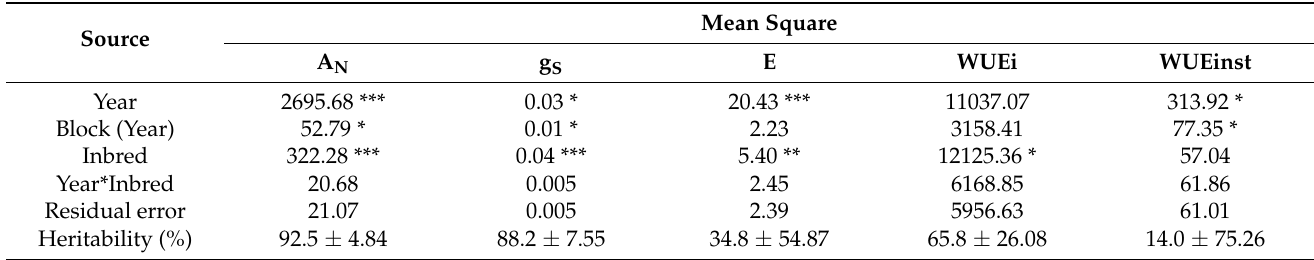
Table 2. Mean squares of the combined analysis of variance of the inbred panel across three years and heritability ( ± standard deviation) estimates for photosynthetic traits.